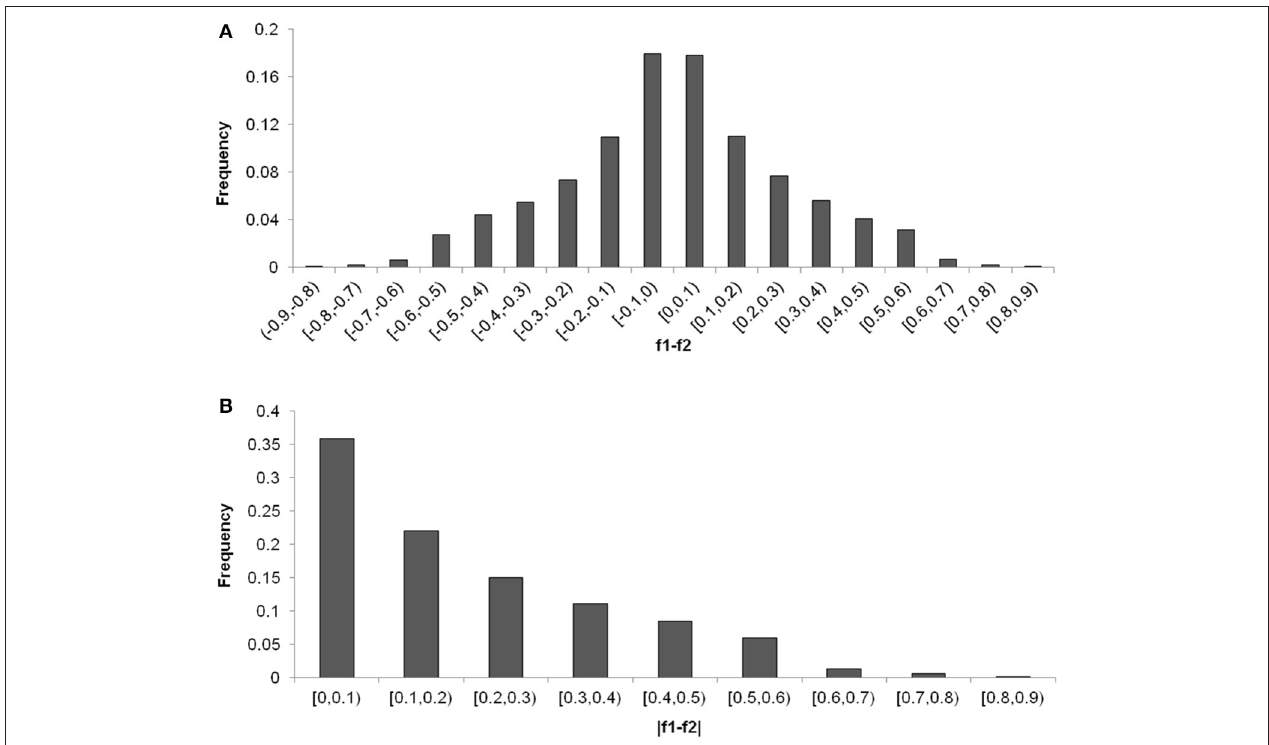
FIGURE 5 | Distribution of the differentiation of allele frequencies, f1-f2 (A) and |f1-f2| ( B , absolute values of f1-f2) between Chinese and American soybean accessions.